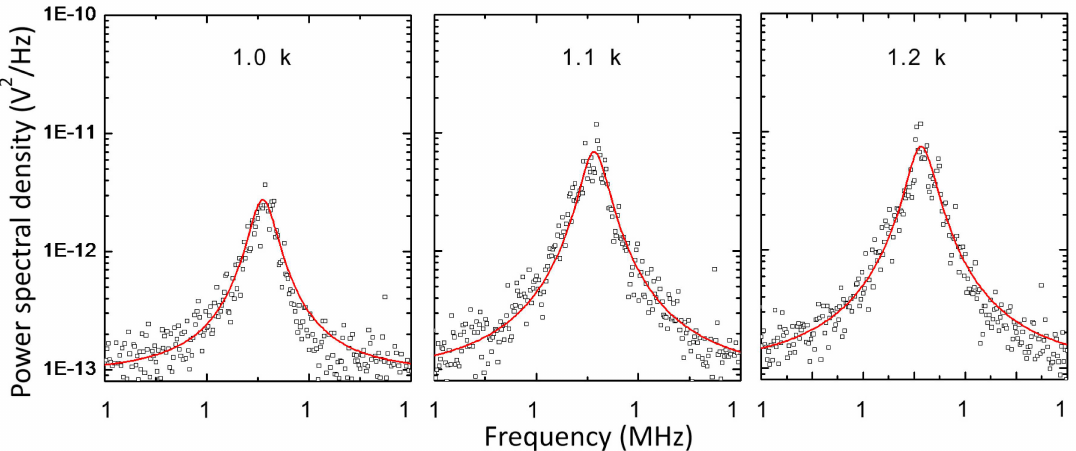
Figure 5. Power spectral density of mass spectrum for insulin under different voltages between the nanomembrane and the extraction gate. Red lines show Lorenztian fit of the power spectral density. As DC voltage increases, the power spectral density increases because it thins and lowers the vacuum barrier more. The resonance frequency of mechanical vibration is independent on the voltage between the nanomembrane and the extraction